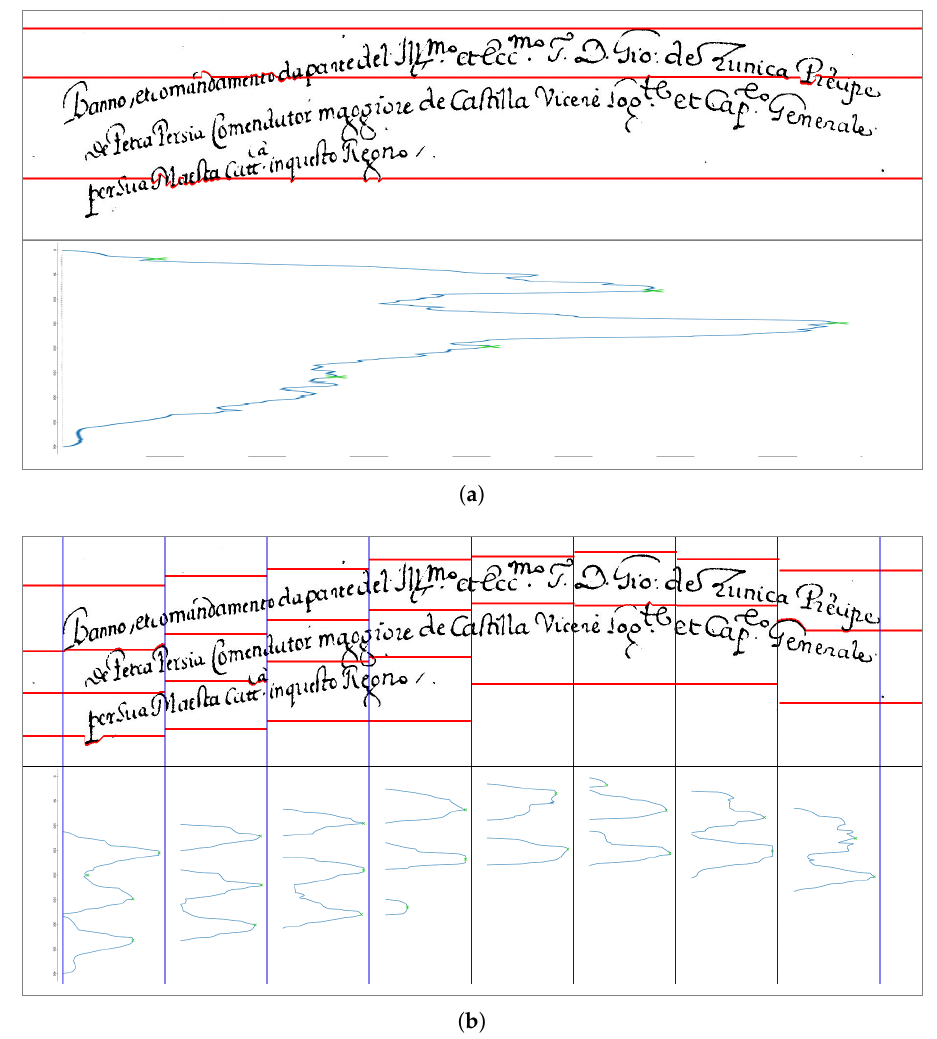
Figure 6. Text-line segmentation in case of lines with curved baseline: ( a ) the result of the original algorithm ( S = 1); ( b ) the result of our algorithm (in the case S = 8 ) .